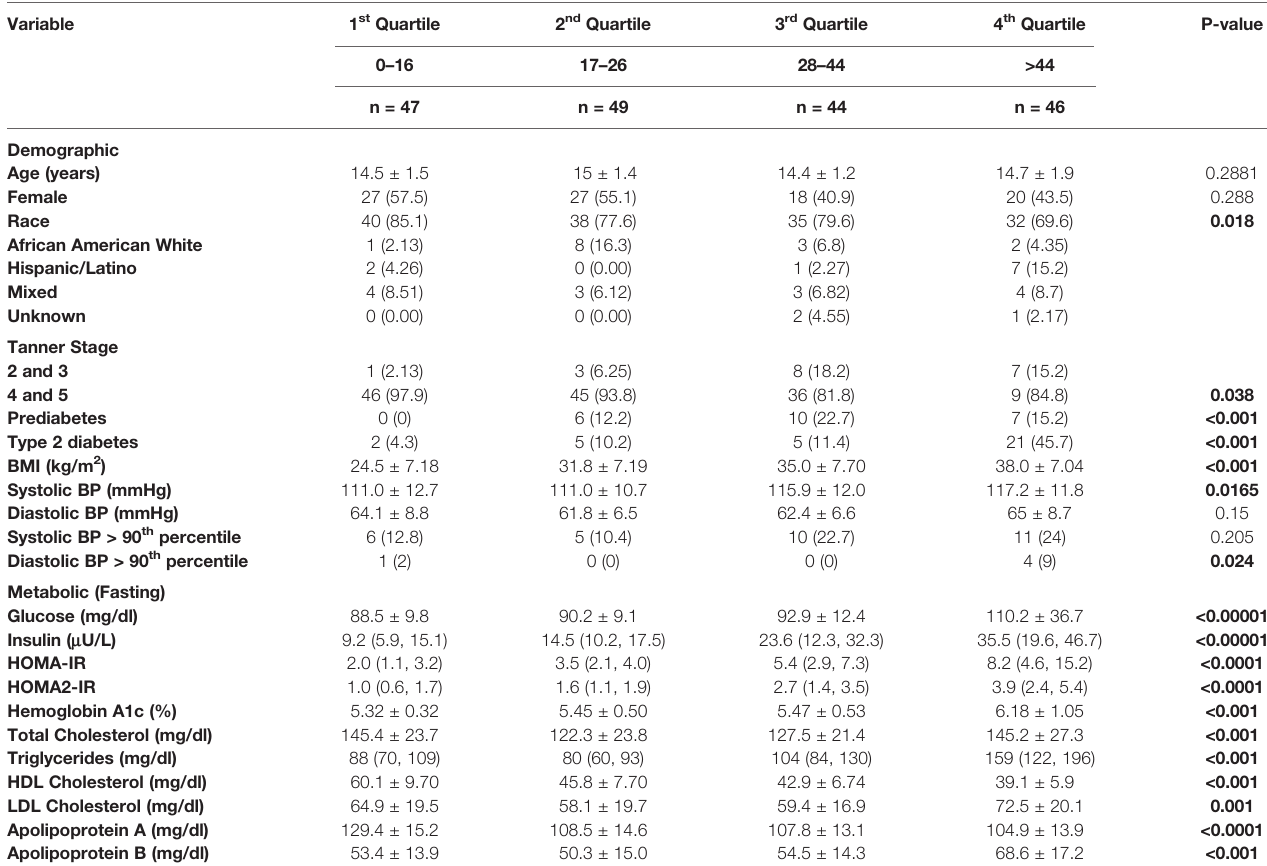
TABLE 3 | Participant demographic and metabolic characteristics and Lipoprotein Insulin Resistance Index Score.